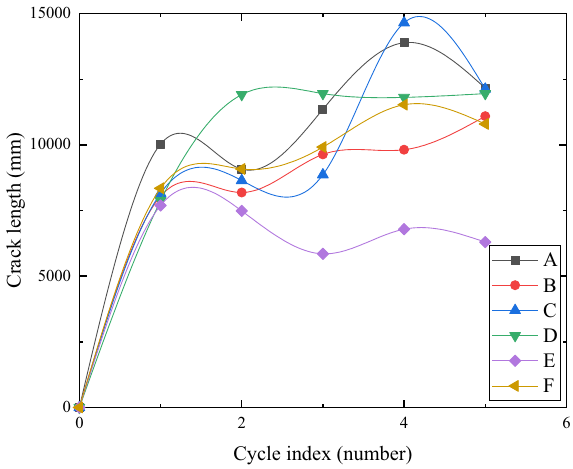
Figure 13. Development of crack length in five dry–wet cycles ( a – e